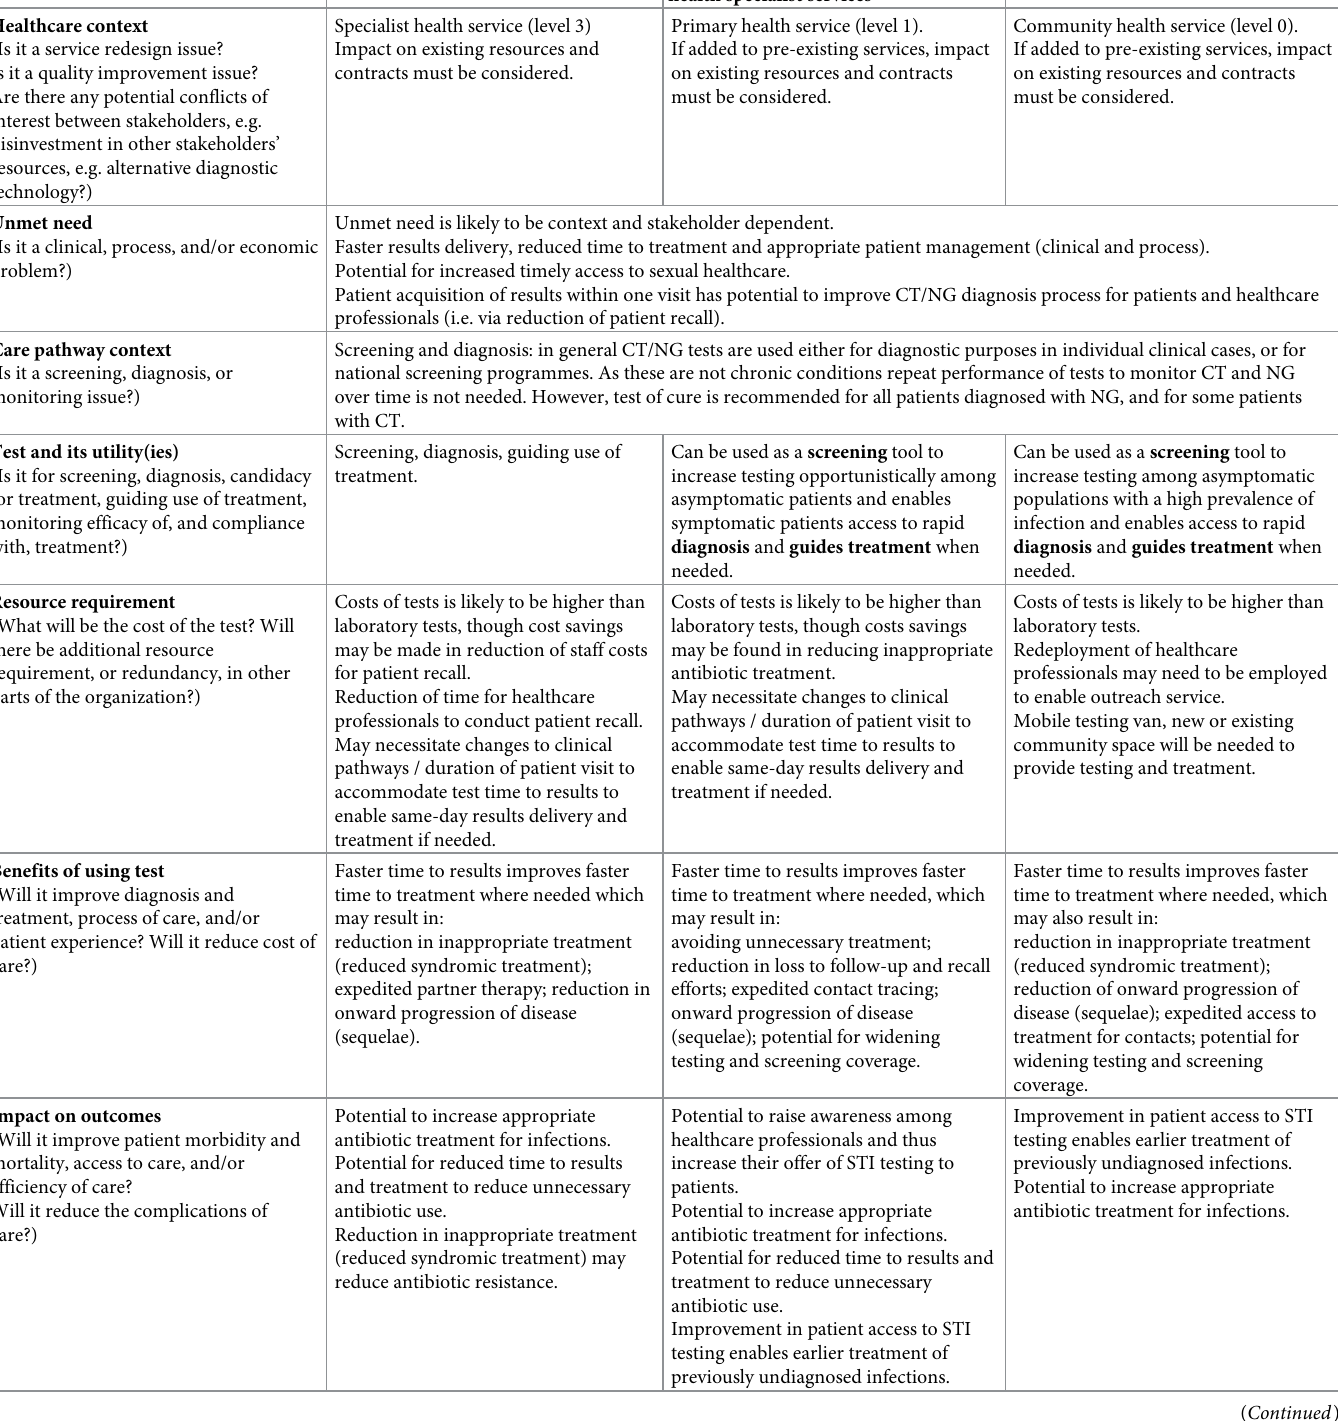
Table 4. Value proposition for molecular CT/NG POCTs by setting type, based on the value proposition for laboratory medicine [35]. Value